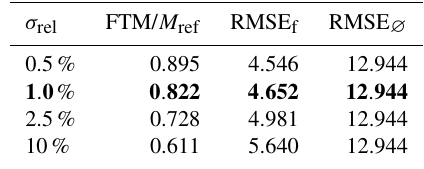
Table 2. Parameters and metrics for assimilation simulations with different values of σ rel , with µ e = 2. FTM is the final total mass, and RMSE f and RMSE ∅ are the concentration field RMSE at the end of simulations with and without